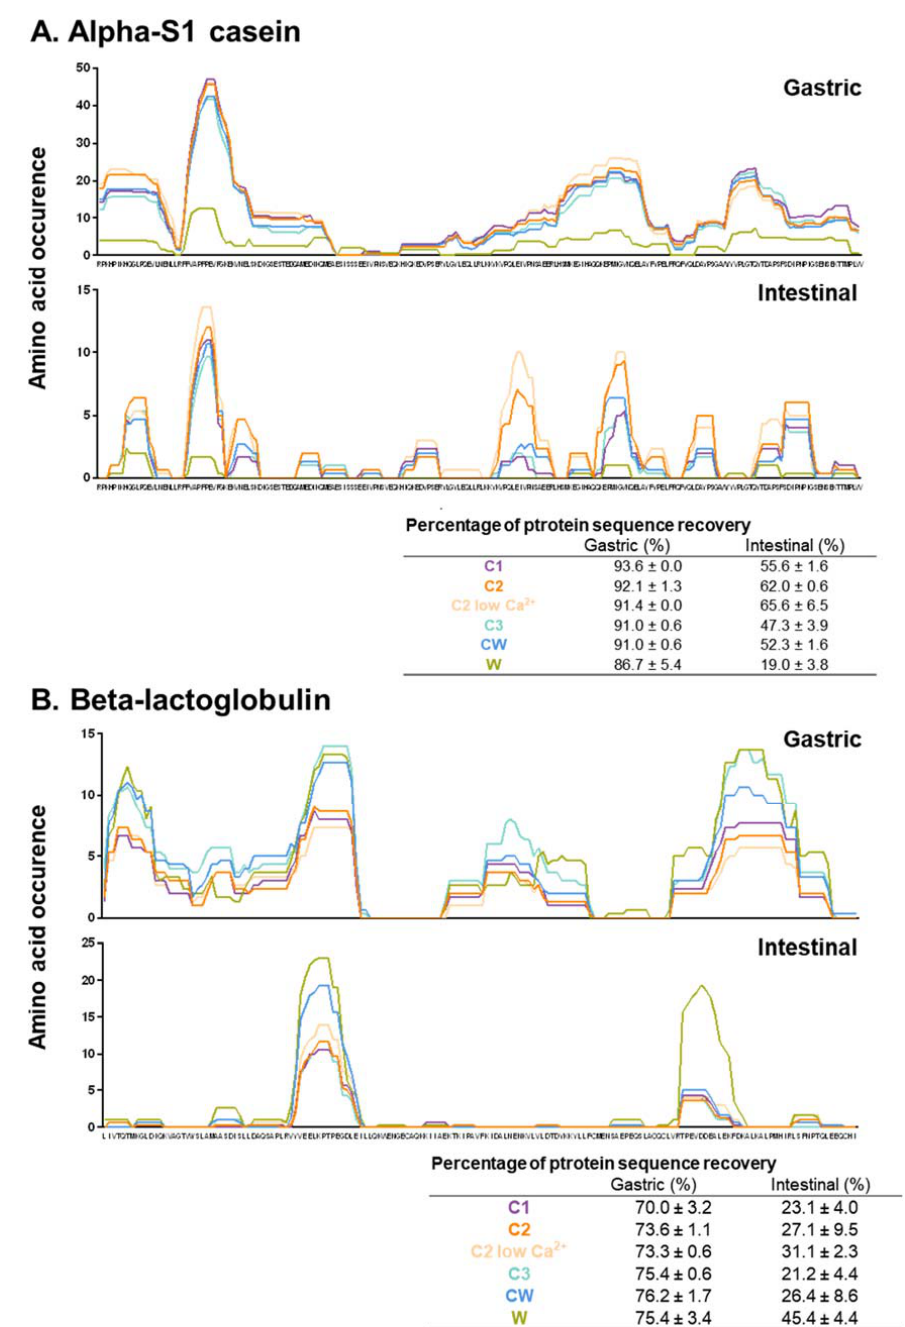
Figure 4. Peptide patterns of the different matrices at the end of the gastric and intestinal phases of the SGID: ( A ) alpha ‐ S1 casein and ( B ) beta ‐ lactoglobulin, with the x ‐ axis representing the amino acid sequence of the different proteins and the y ‐ axis representing amino acid occurrence.